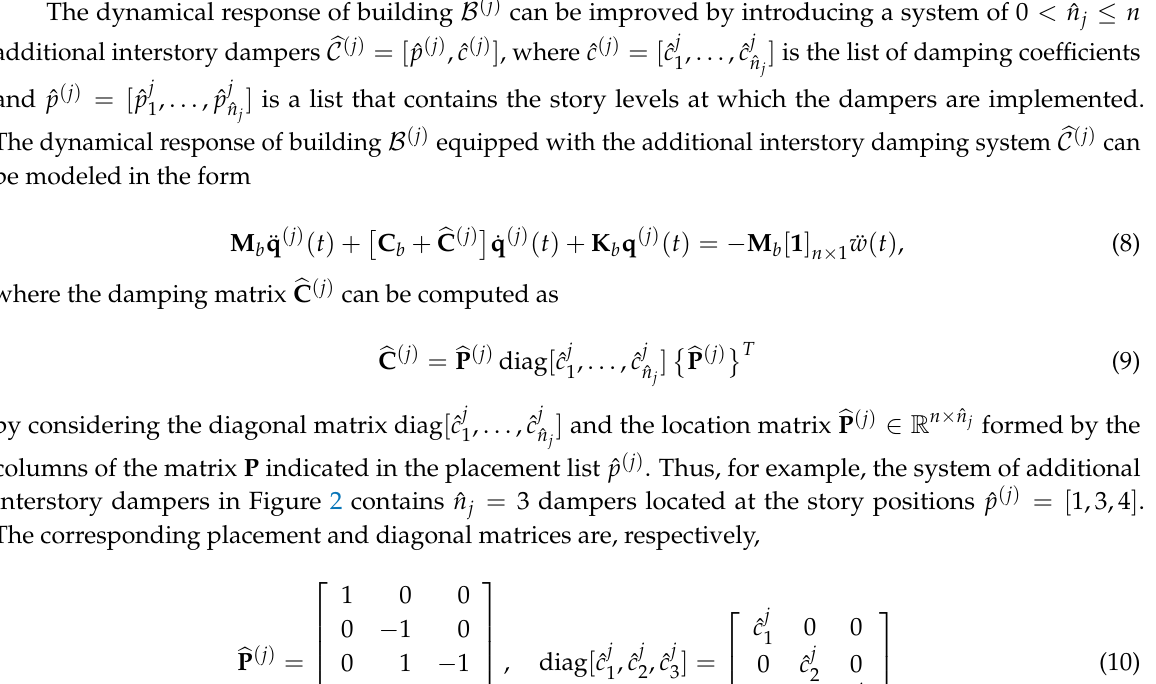
= 1, ˆ p j = 3 and ˆ p j = 2 3 1